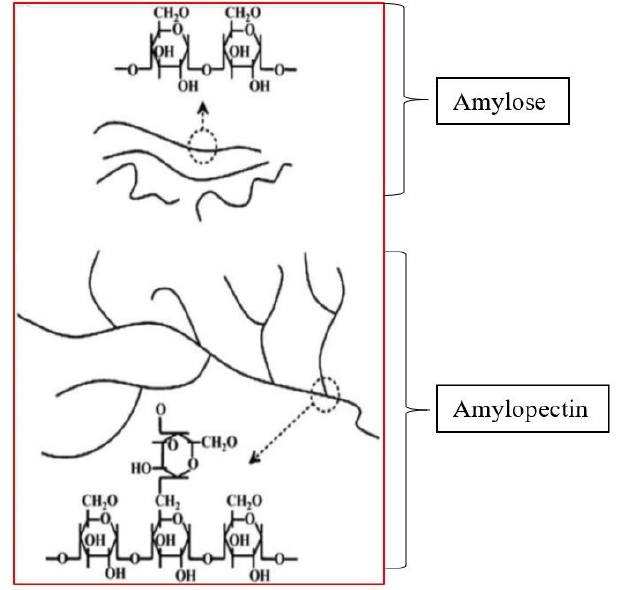
Figure 2. Chemical representation of two kinds of microstructures in starch Modified from Jiang et al.